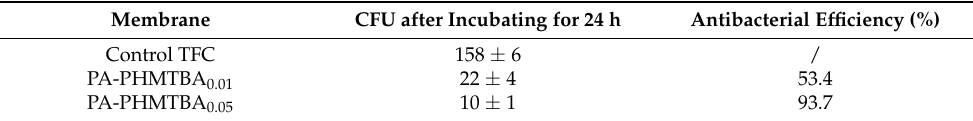
Table 2. Antibacterial property of the as-prepared TFC